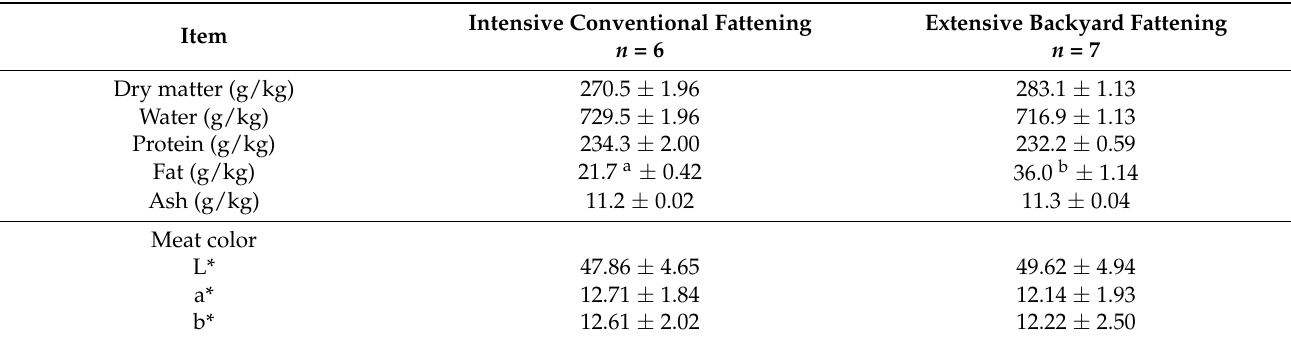
Table 4. Chemical analysis and quality indices of meat ( m.longissimus dorsi ) (means ±